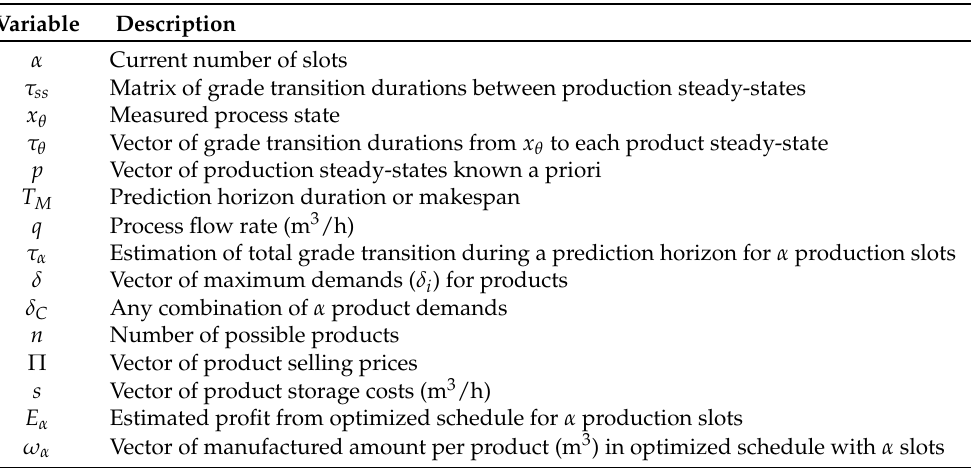
Table 4. Variable